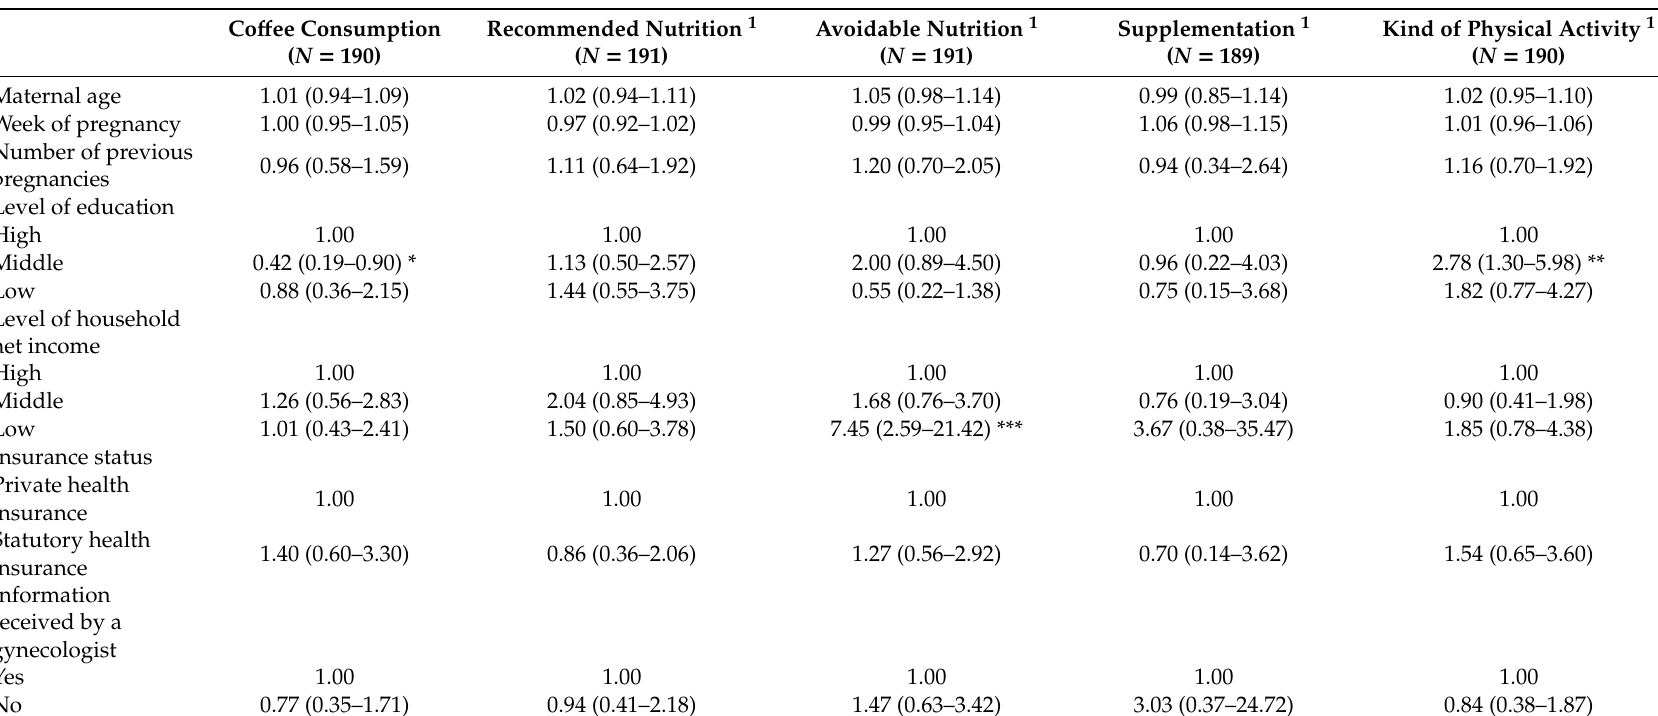
Table 4. Risks of non-compliant knowledge of lifestyle-related risk factors during pregnancy in association with independent variables, expressed in odds ratios (95% confidence